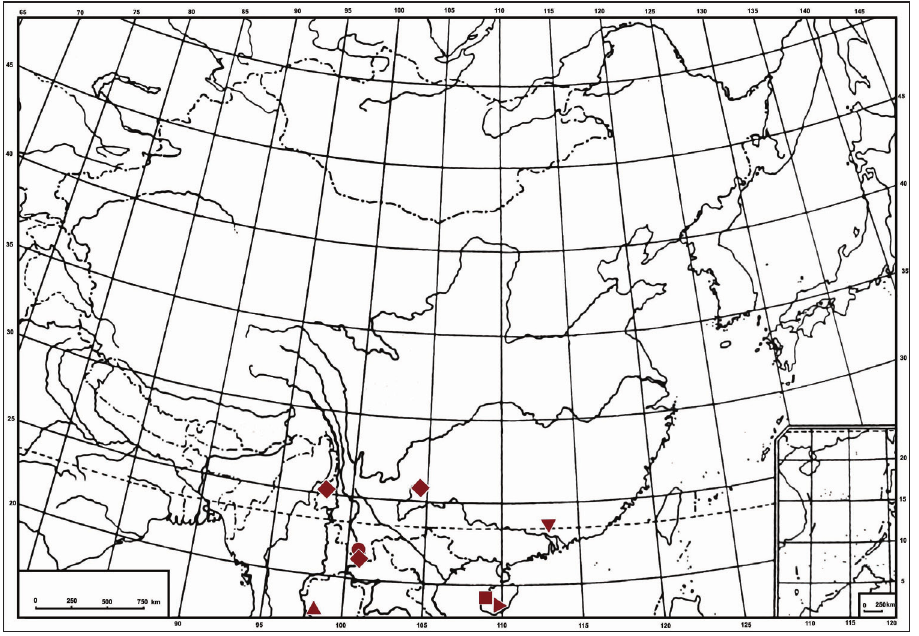
Figure 37. Geographic distribution of Symplanella species: S. recurvata sp. n. ( ▼ ); S. brevicephala (Chou, Yuan & Wang) ( ♦ ); S. breviceps Fennah ( ▲ ); S. hainanensis sp. n. ( ► ); S. unipuncta Zhang & Wang ( ■ ); S. zhongtua sp. n. ( ●